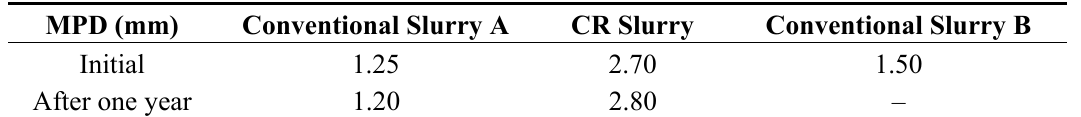
Table 1. Mean Profile Depth (MPD) index obtained from macrotexture measurements at different points on the analyzed test